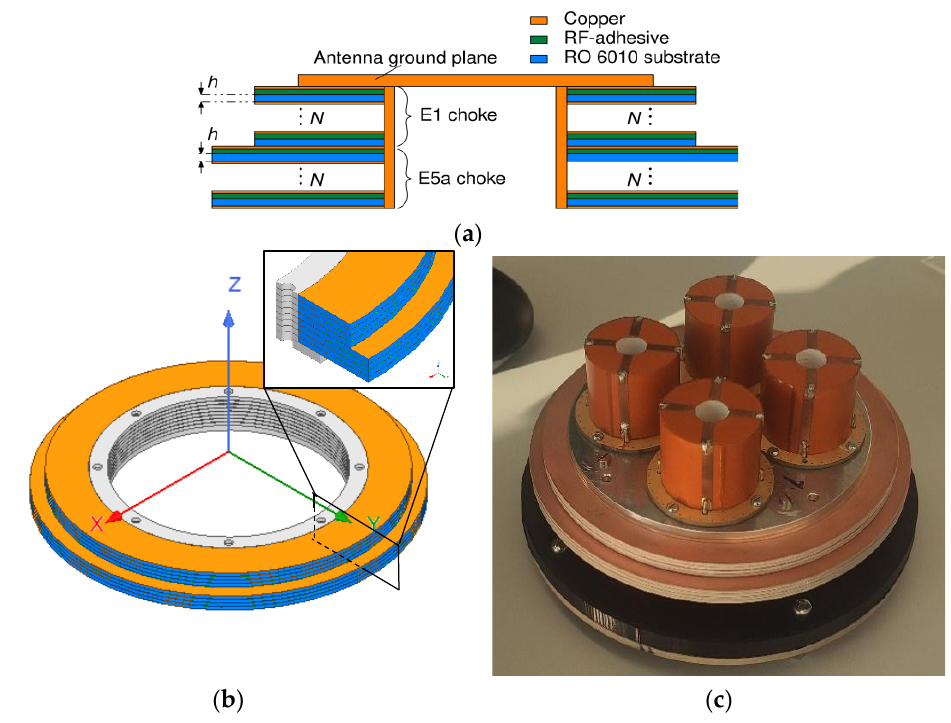
Figure 5. Miniaturized vertical choke rings for multipath mitigation. ( a ) Schematic; ( b ) Isometric view of the choke rings; ( c ) Manufactured vertical choke rings with antenna array.